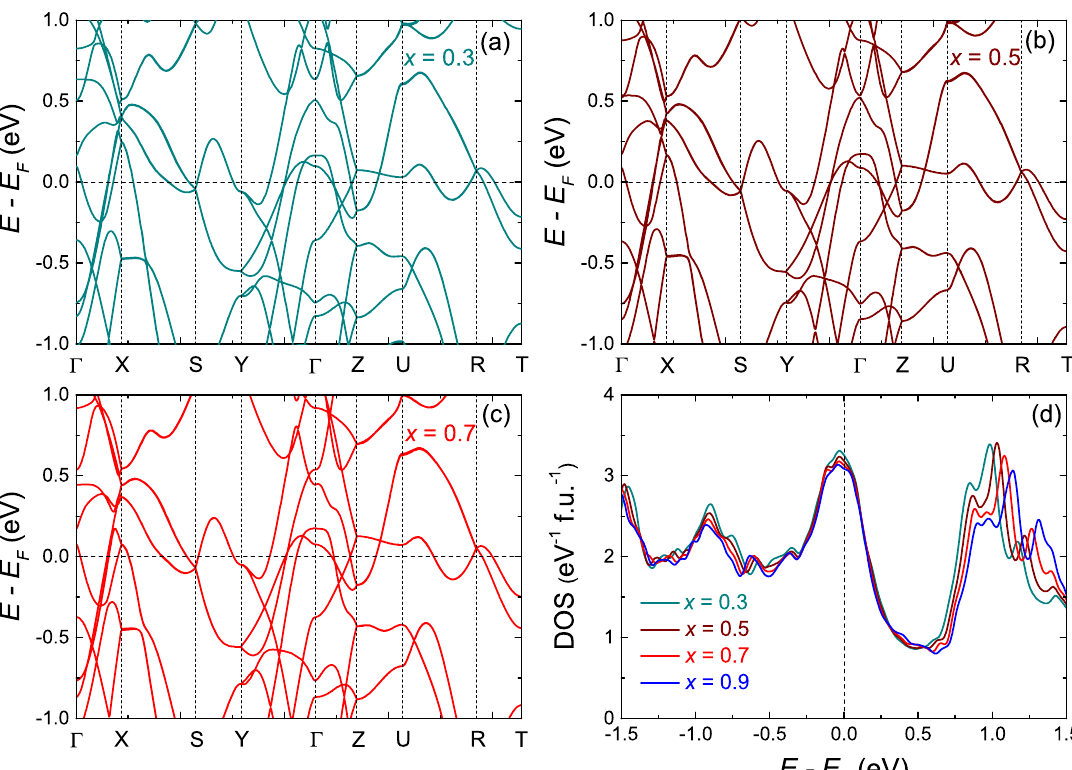
Fig. 7 Calculated electronic band structure of β -ThRh 1 − x Ir x Ge. a – c Electronic band structure without SOC for β -ThRh 1 − x Ir x Ge with x = 0.3, 0.5, and 0.7, respectively. d Total density of states plotted as a function of energy for x = 0.3, 0.5, 0.7, and 0.9. The vertical dashed line indicates the position of Fermi